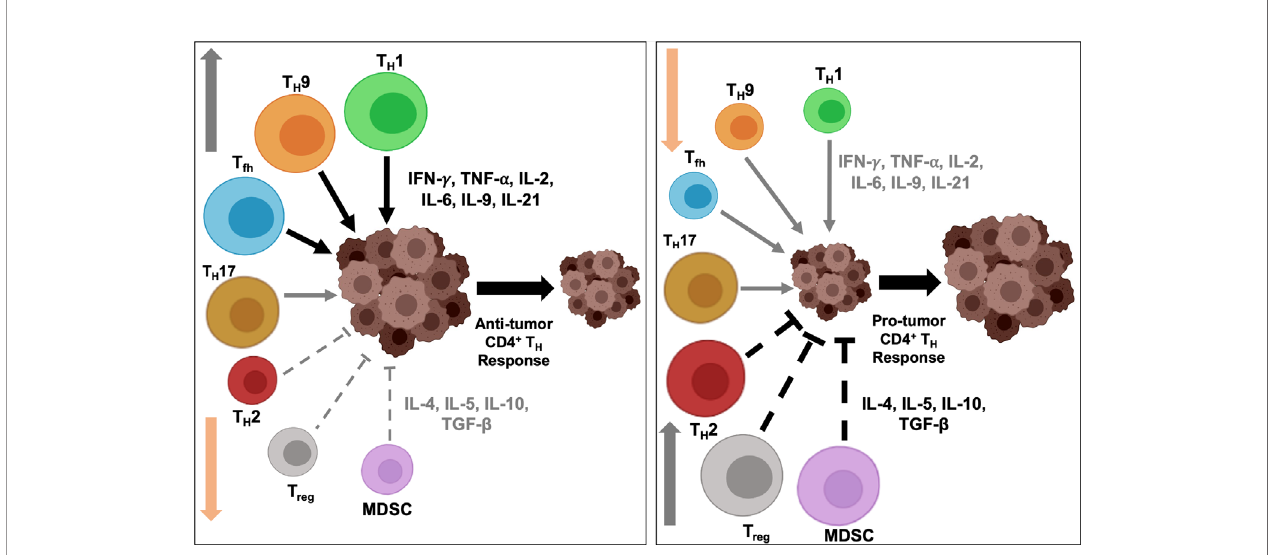
FIGURE 2 | Intratumoral balance of anti- vs pro-tumorigenic CD4 + T H cells determine immune response outcome. Activation and downregulation of speci fi c T H cells modulate intratumoral balance of stimulatory and suppressive effectors and modulates tumor response to immunotherapy. Polarization and activation of T H 1, T H 9 and T fh subtypes induce secretion of proin fl ammatory cytokines, and, coupled with simultaneously diminished activity of immunosuppressive T H 2 and T reg cells, tip the balance towards anti-tumor immune response and induce tumor regression ( left) . On the contrary, heightened activity of the immunosuppressive populations and secretion of inhibitory cytokines, and concurrent downregulation of immunostimulatory T H 1, T H 9 and T fh cells induce a protumorigenic microenvironment, resulting in disease progression ( right ). To shift the balance to either end of the equilibrium, a concerted effort by multiple T H subtypes are necessary and may not be achieved by alteration in the functional state of a single T H